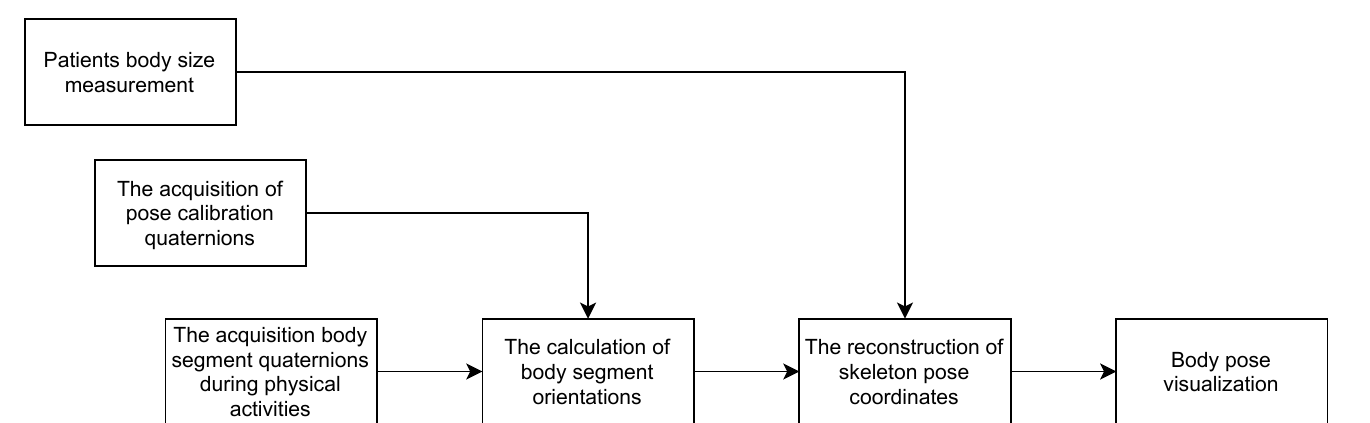
Figure 7. Flowchart of the proposed method for human skeleton 3D model and movement